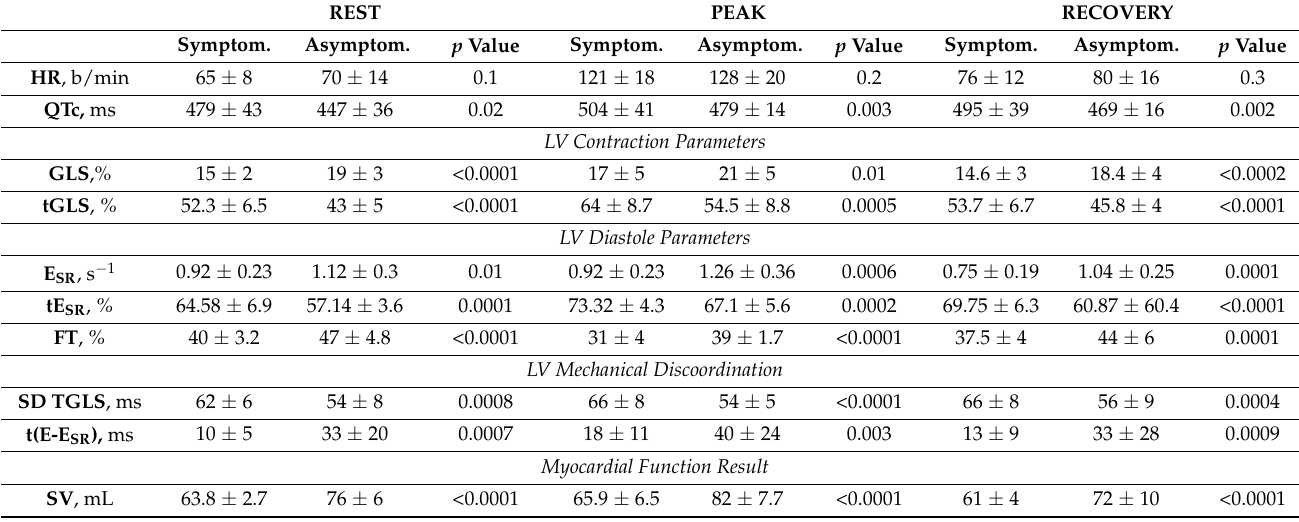
Table 2. Comparisons between symptomatic and asymptomatic LQTS mutation carriers. REST PEAK RECOVERY Symptom. Asymptom. p Value Symptom. Asymptom. p Value Symptom. Asymptom. p